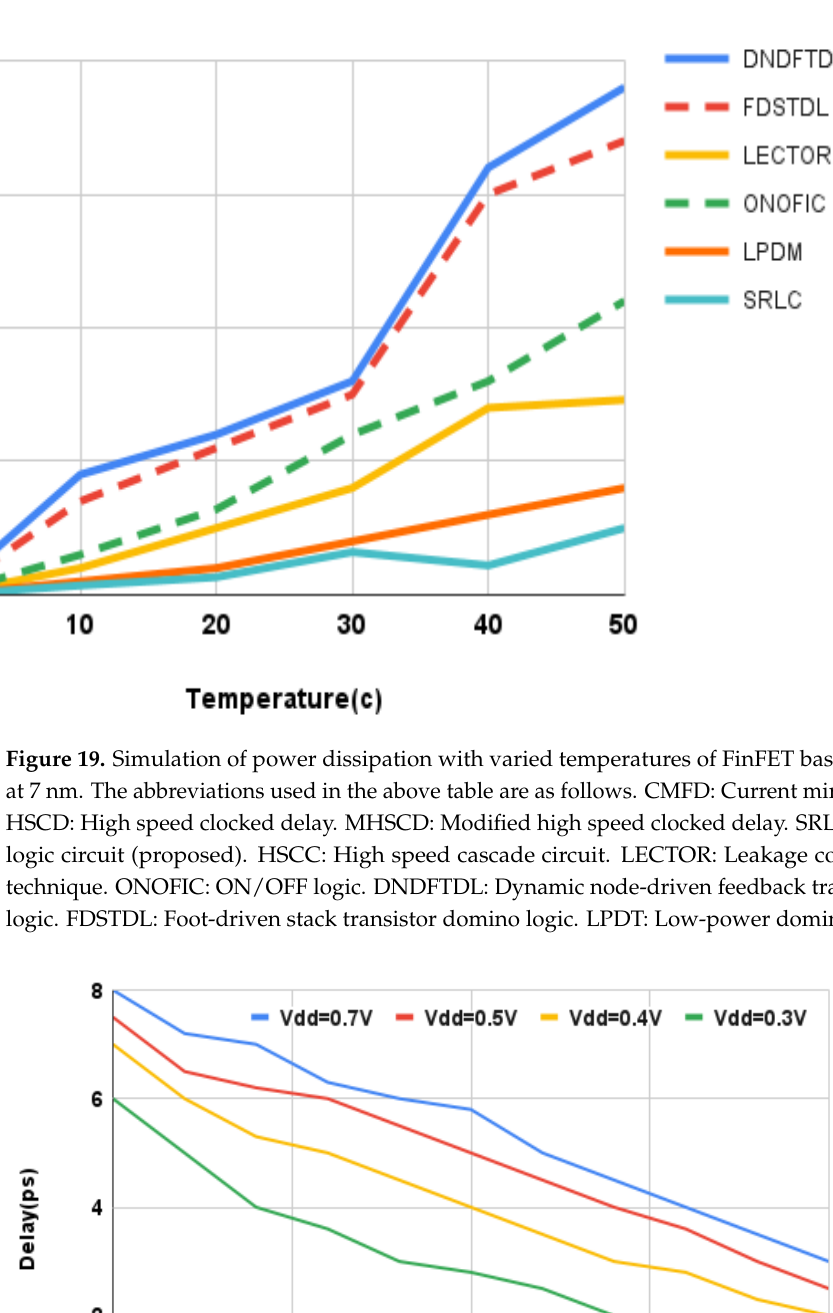
Figure 18. Simulation of delay with a supply voltage of FinFET-based circuits at 7 nm.